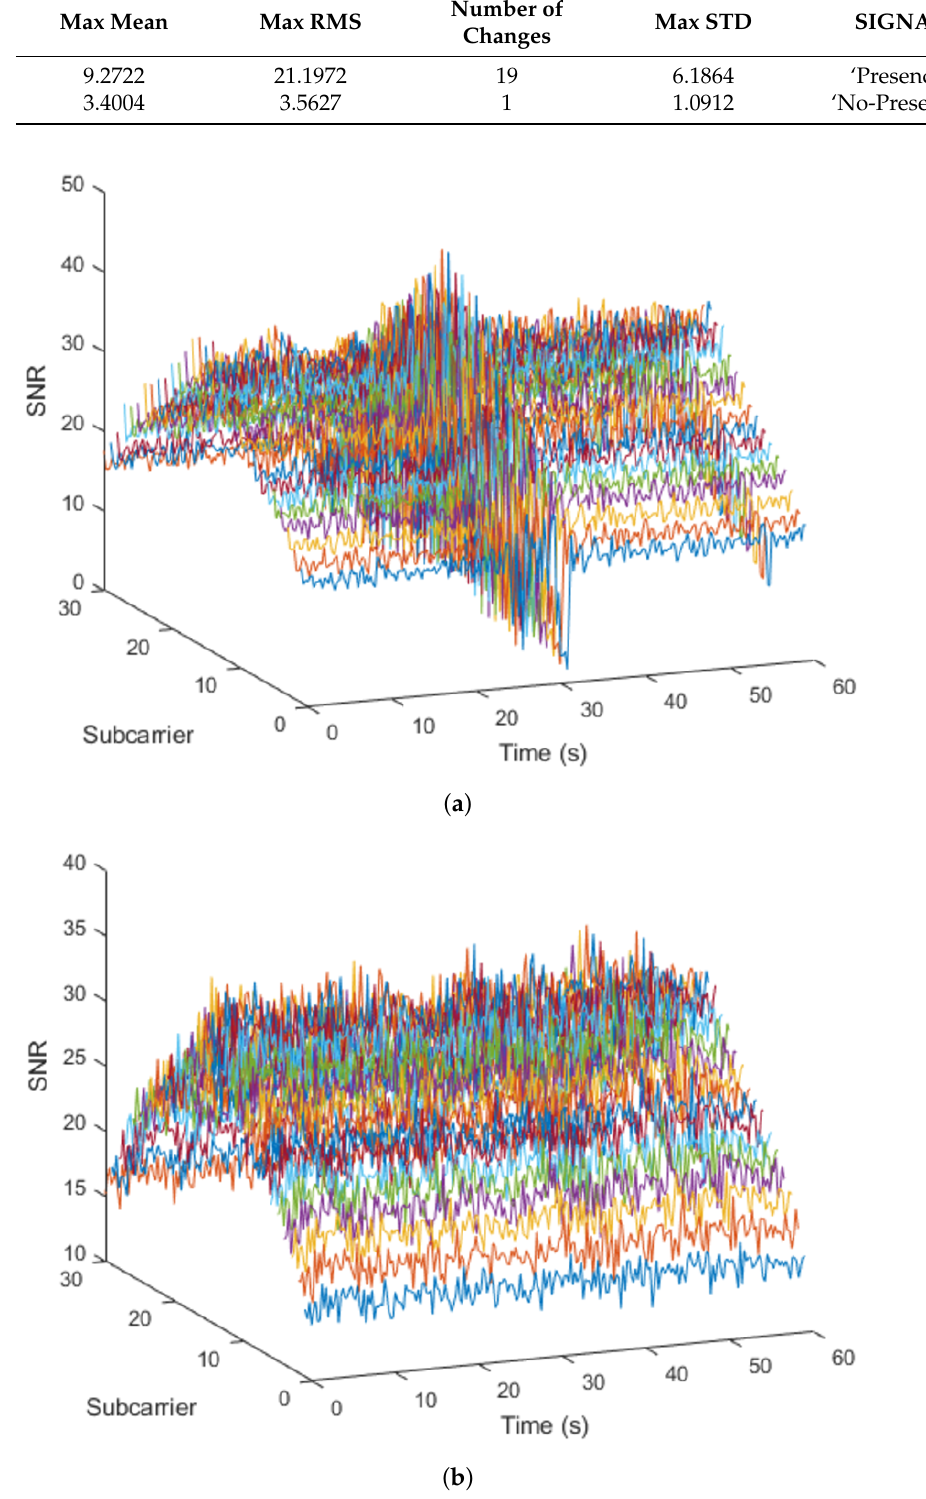
Figure 3. CSI amplitude representation: ( a ) with human presence; ( b ) without human